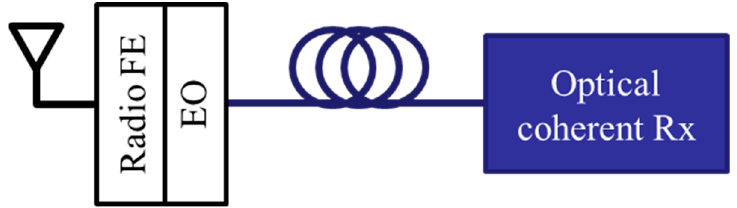
Figure 3. Configuration of RoF optical-to-radio interface for radio-wave radiation.